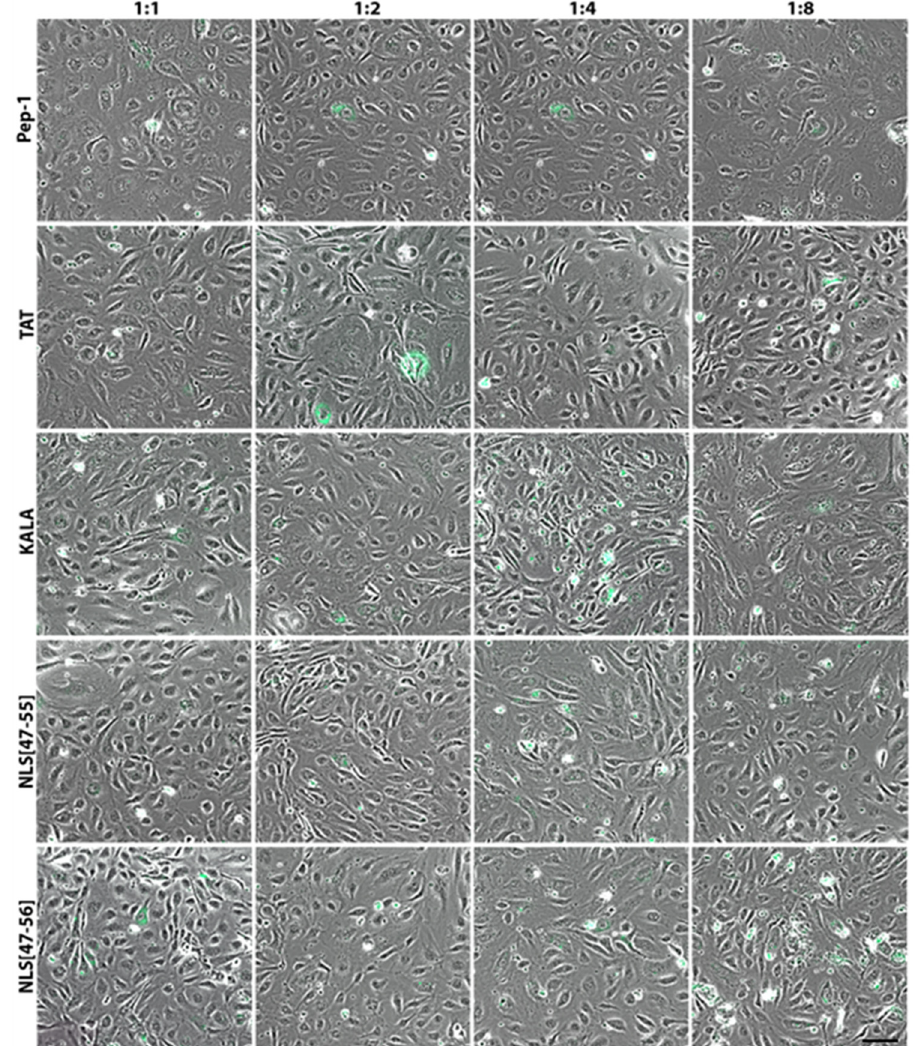
Figure 13. Results of 24 h culture in the presence of complexes in CRs of 1:1, 1:2, 1:4 and 1:8. The complexes were formed using incubation of 2 μ g pmaxGFP with chosen CPPs at 37 °C for 30 min. CR, charge ratio. ( A ) Transfection efficiency. ( B ) Percent of cells with abnormal morphology. Data are presented as means, numbers in parentheses represent standard deviations.